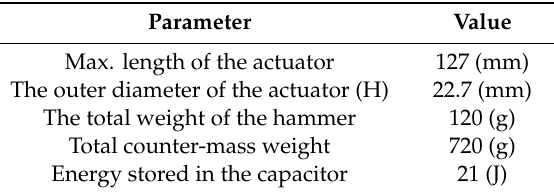
Table 1. High-end parameters of the tube reluctance actuator derived after the laboratory model tests and simulation